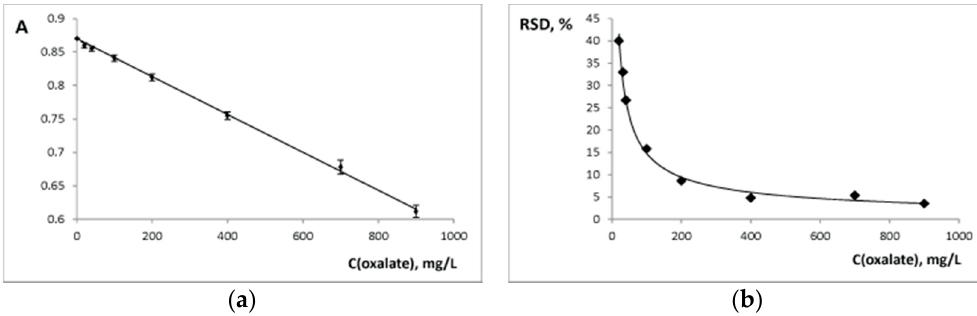
Figure 7. ( a ) Calibration curve for oxalate determination with Si-Ti/ECR ( λ 570 nm, pH 3.0, m/V = 0.10 g/ 5.0 mL, time of contact is 15 min), standard deviations for absorbance are given ( n = 3); ( b ) The dependence of relative standard deviation of concentration of the oxalate found (RSD) on the concentration of the oxalate added ( n = 3).